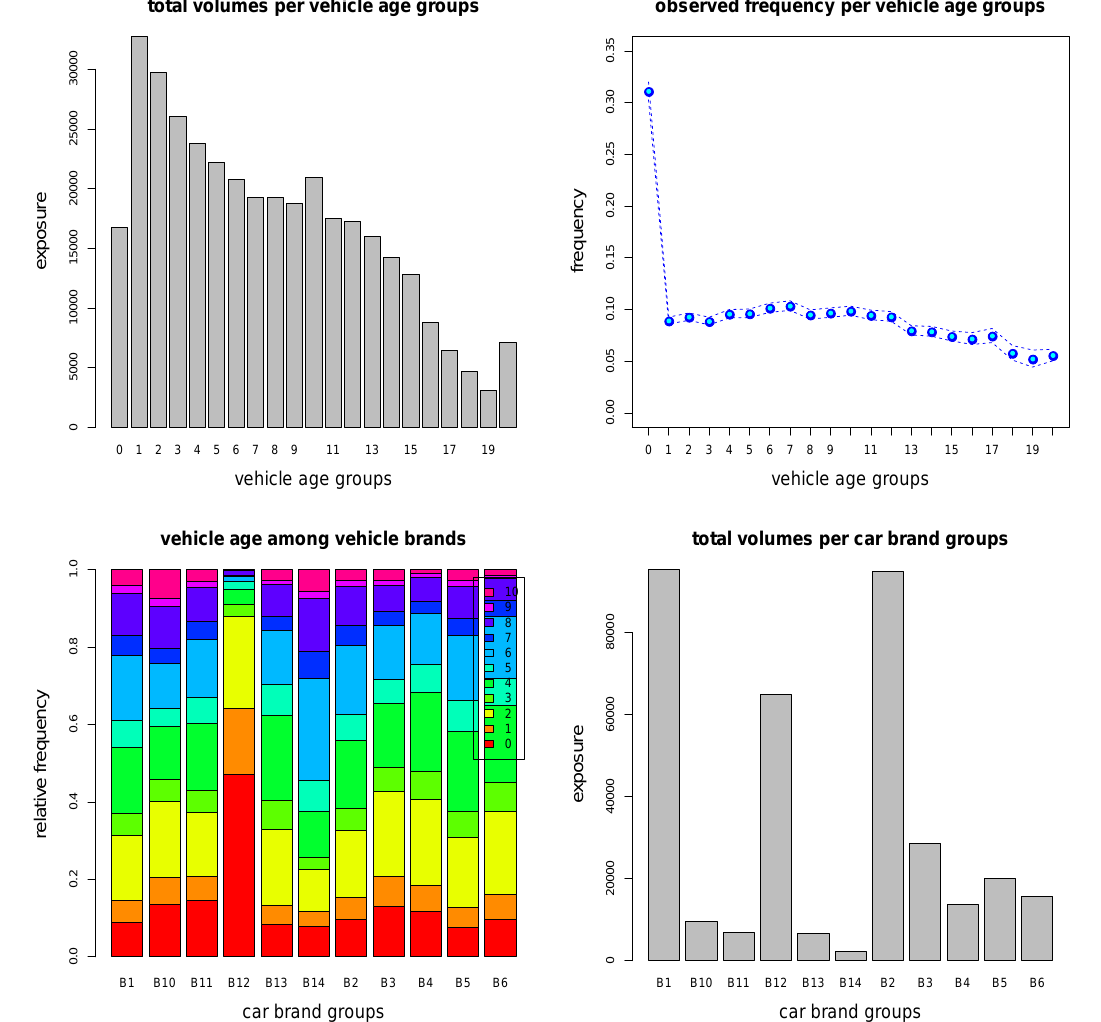
Figure 7. Empirical plots of VehAge s: ( top lhs ) exposure per vehicle ages, ( top rhs ) marginal frequencies per vehicle ages, ( bottom lhs ) interaction vehicle age and vehicle brand, ( bottom rhs ) exposures per vehicle